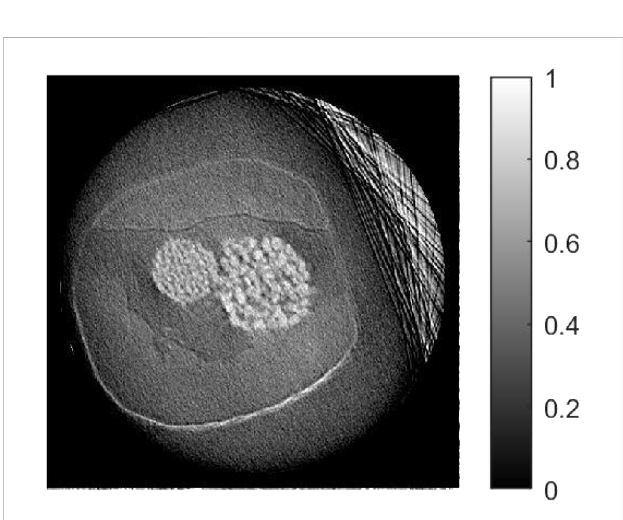
FIGURE 16 One slice of the reconstruction results: without phase removal.